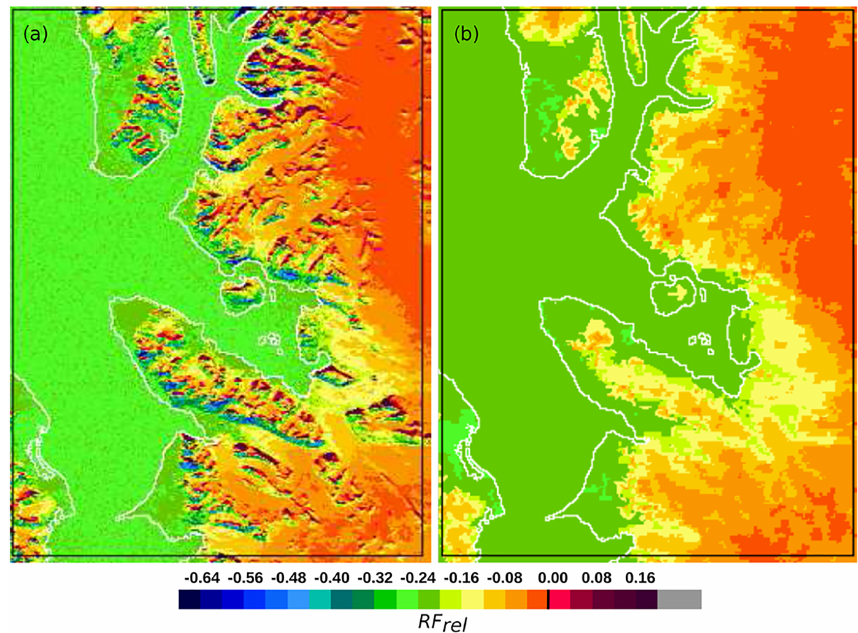
Figure 6. A comparison of the RF rel spatial variability at the Earth’s surface derived from the 3-D Monte Carlo model (a) with RF pp variability (b) computed, applying the Monte Carlo model with plane-parallel geometry to each column independently. In panel (b) both the surface topography and photon exchange between adjacent columns are neglected. Computations for λ = 469nm, solar zenith angle = 57 ◦ , solar azimuth = 173 ◦ , and aerosol properties of 10 July 2015, 11:30UTC.